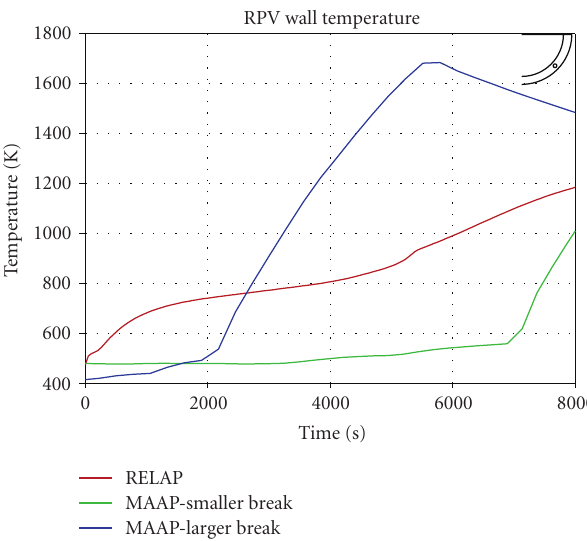
Figure 19: Temperature of the wall of the RPV lower head after relocation of molten material (the red dot on the figure in the upper right corner represents the position at the RPV wall where the temperature was